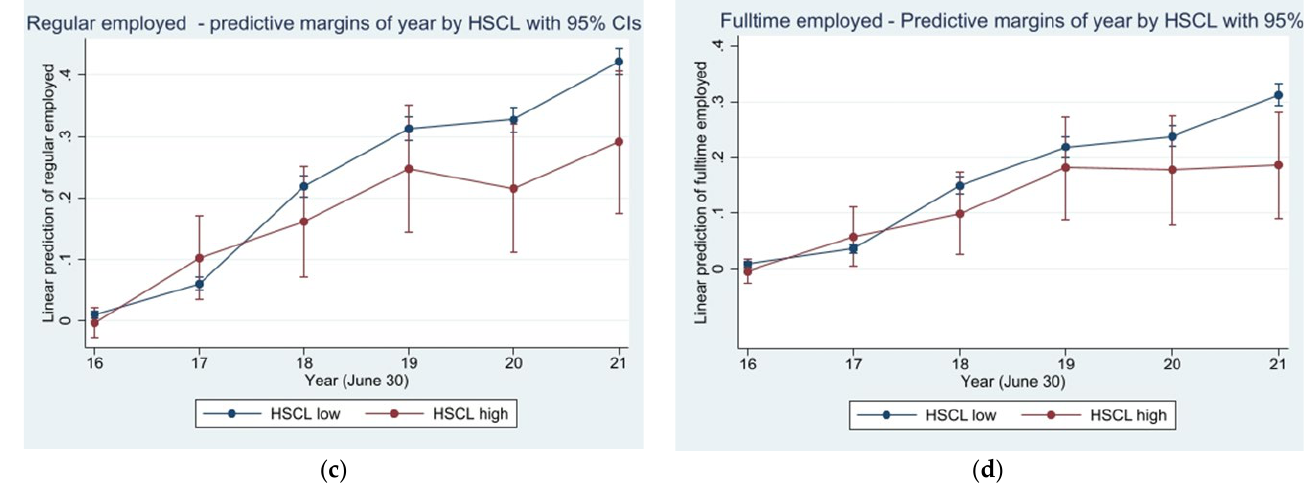
Figure A2. Predictive margins of year by mental disorder screening diagnosis (HSCL). ( a ) Labor market integrated (wide definition). ( b ) Employed (full-time, part-time, or marginal employed). ( c ) Regular (full-time or part-time) employed. ( d ) Full-time employed. Source: IAB-WELLCOME study wave 1; IEB, V16.01. Table A1. Effects of PTSD screening diagnosis in 2016 on being employed—2016–2021—OLS regression.